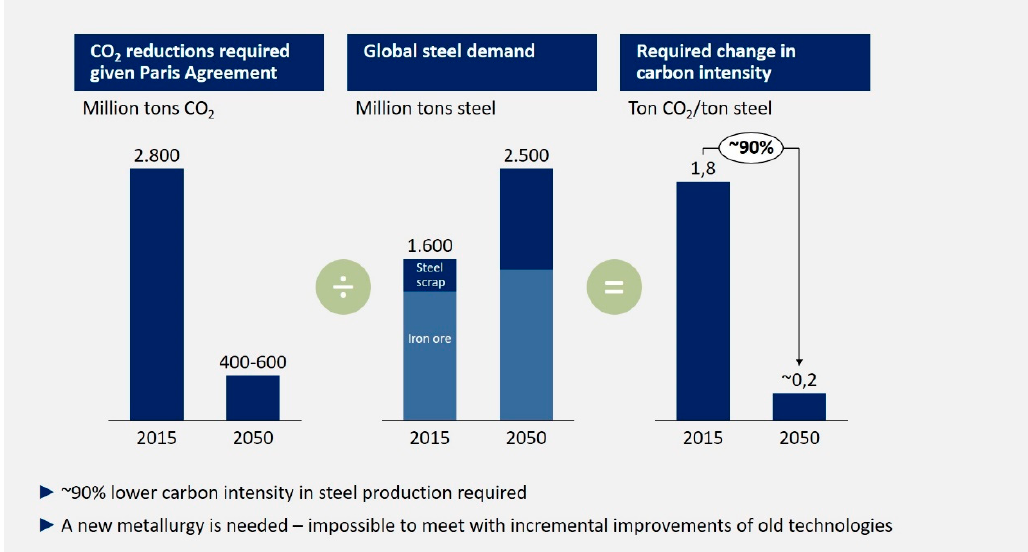
Figure 1. Global steel demand and required decrease of CO 2 emissions in 2050, data from [1].